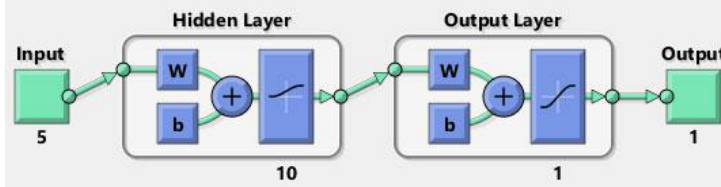
Figure 11. ANN model for natural fundamental period estimation. The network structure presented in Figure 10 was first trained with the obtained data set. The performance of the network in the training process is shown in Figure 12.